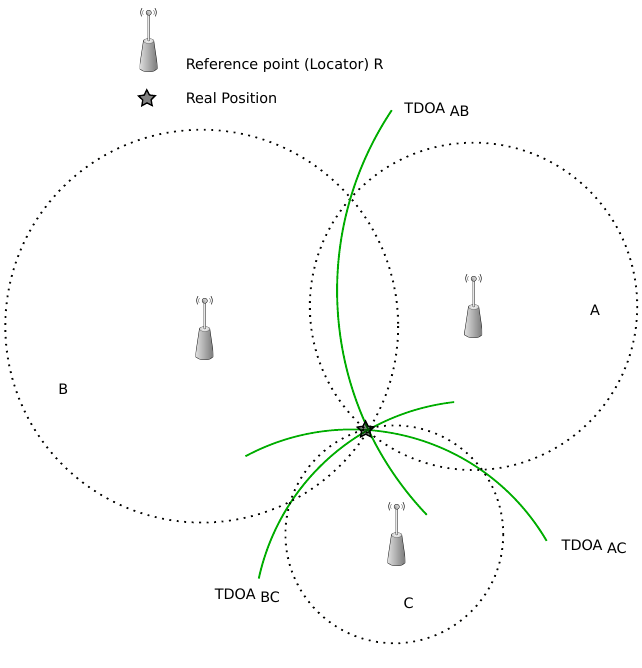
Figure 6. Time difference of arrival (TDoA)-based